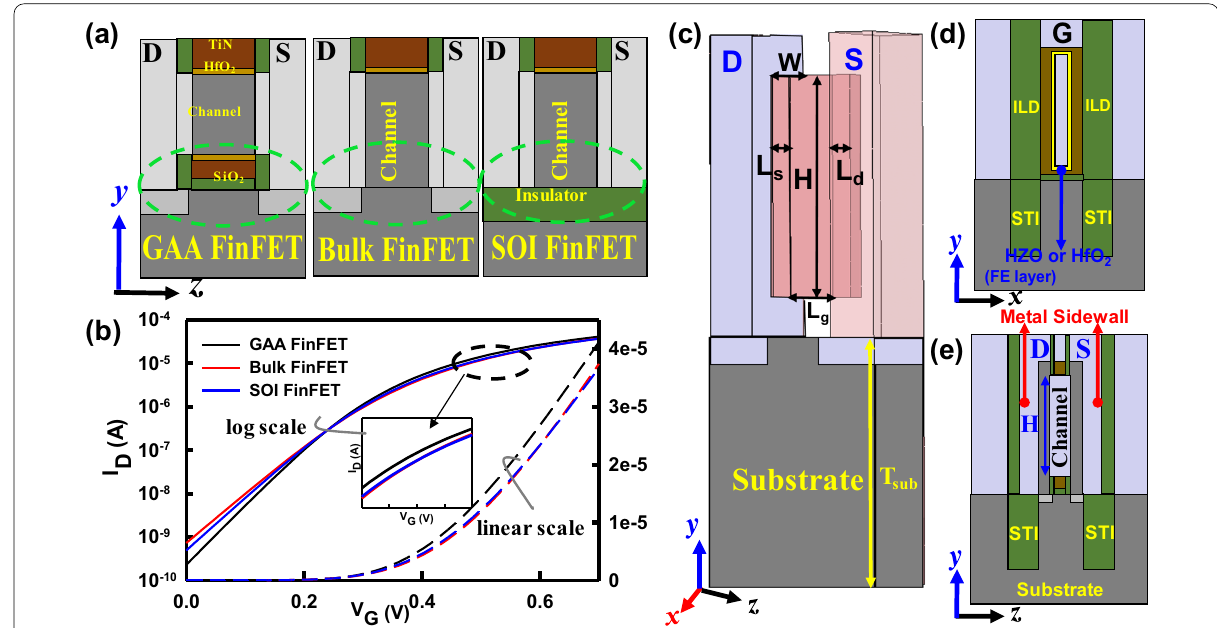
Fig. 2 a The schematic plots of GAA, bulk and SOI FinFETs, respectively. b The I D – V G comparison among the three structures at V D schematic of the GAA FinFET. A cross section of the 3D structure d in the x–y plane and e in the z–y plane